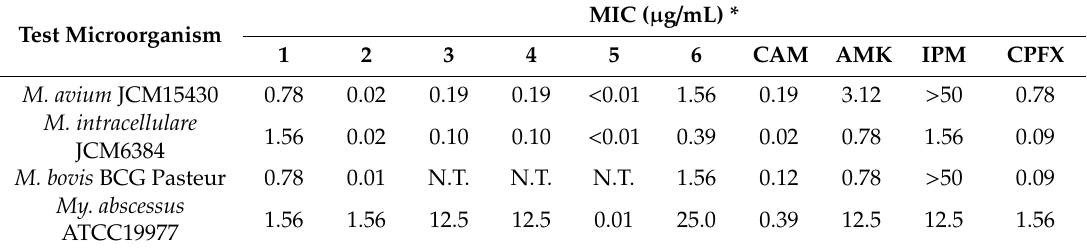
Table 2. MIC and ED 50 values of anti-mycobacterial agents against My. abscessus. Test Compound